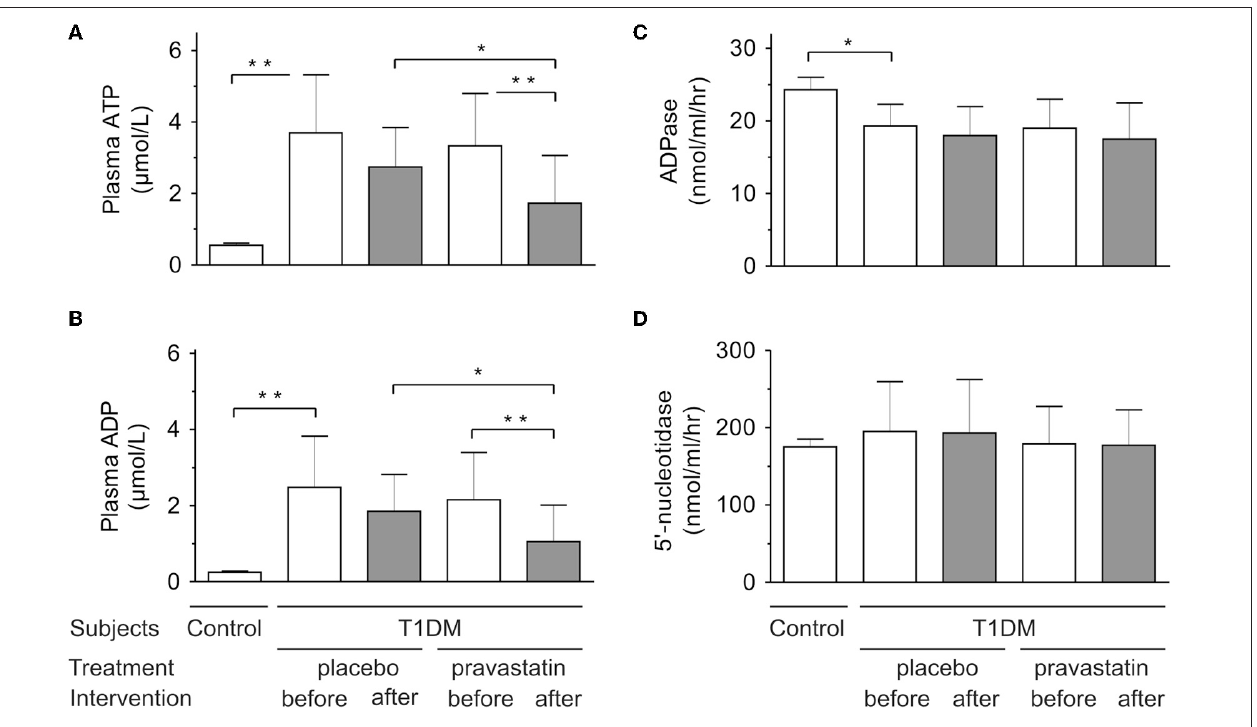
FIGURE 1 | EffectofpravastatintreatmentoncirculatingnucleotideATP(A)andADP(B)levelsandsolublenucleotidaseADPase(C)and5 (cid:2) -nucleotidase activities (D) in type 1 diabetic patients (pravastatin n = 22, placebo n = 20). Control refers to healthy subjects ( n = 41). ∗ p < 0 . 05; ∗∗ p < 0 .